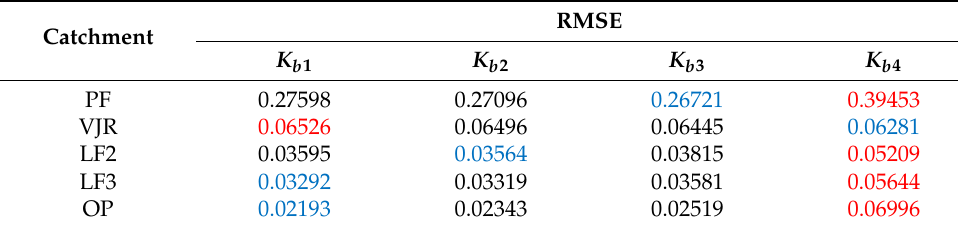
Table 3. Root mean squared error (RMSE) of prediction in the different land-uses.